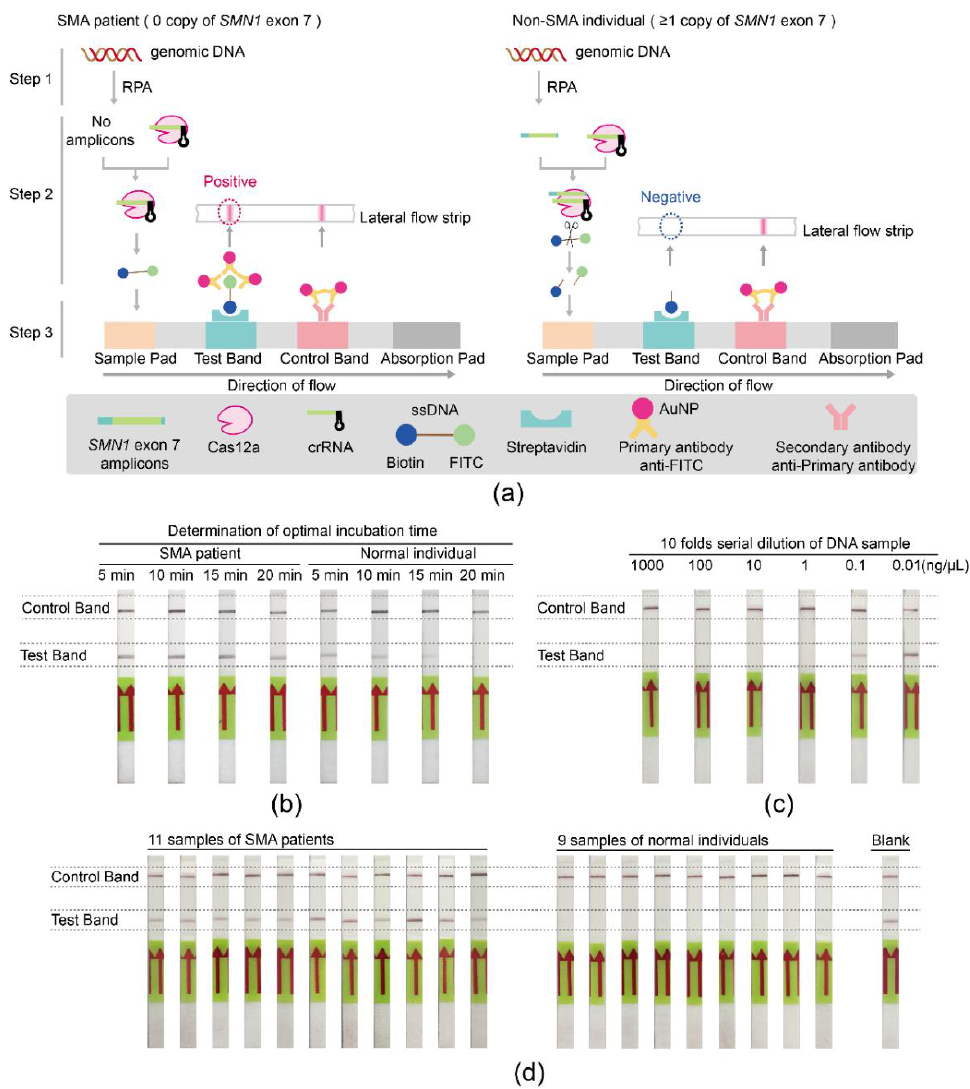
Figure 3. Schematic diagram and validation of the SMA-Cas12a-strip assay. ( a ) For SMA patients with the homozygous deletion of SMN1 exon 7, no SMN1 exon 7 amplicons were amplified by RPA (Step 1). Without activation by the amplicons, Cas12a could not cleave the ssDNA probe (Step 2). The products of the Cas12a cleavage reaction were mixed with the buffer and then added to the sample pad of the lateral flow strip. The intact ssDNA probe migrated toward the absorption pad and was captured by streptavidin, which was immobilized at the test band. Subsequently, the FITC was recognized and bound by the primary antibody that was conjugated with gold nanoparticles (AuNP). The aggregation of AuNP at the test band generated a red line, which indicated the integrity of the probe, the inactivation of Cas12a, and the homozygous deletion of SMN1 exon 7. The excessive primary antibody coupled with AuNP continued migrating toward the absorption pad and was captured by the secondary antibody that was immobilized at the con- trol band. The aggregation of AuNP at the test band generated another red line, which indicated the success of the assay and the validity of the result (Step 3). On the contrary, there was at least one copy of SMN1 exon 7 in non-SMA individuals, which could be amplified by RPA (Step 1). Amplicons triggered Cas12a and activated Cas12a degraded the ssDNA probe through the collat- eral cleavage activity, leading to the separation of FITC and biotin (Step 2). When the products of the Cas12a cleavage reaction were mixed with the buffer and added to the sample pad, the biotin terminal of the ssDNA probe was captured at the test band by streptavidin, but the FITC terminal was not retained at the test band. Thus, there was no aggregation of AuNP and no red line at the test band, which indicated the degradation of the probe, the activation of Cas12a, and the exist- ence of SMN1 exon 7. Primary antibody and AuNP aggregated at the test band and generated a red line. Briefly, only one red line at the control bands was considered as negative, indicating the